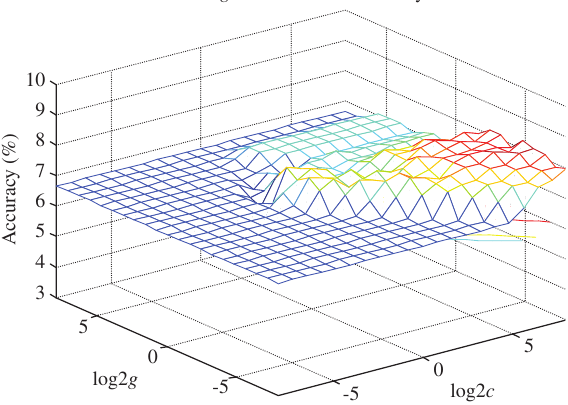
Figure 7: 3D Figure of the Optimized Results of the Fifth Group of